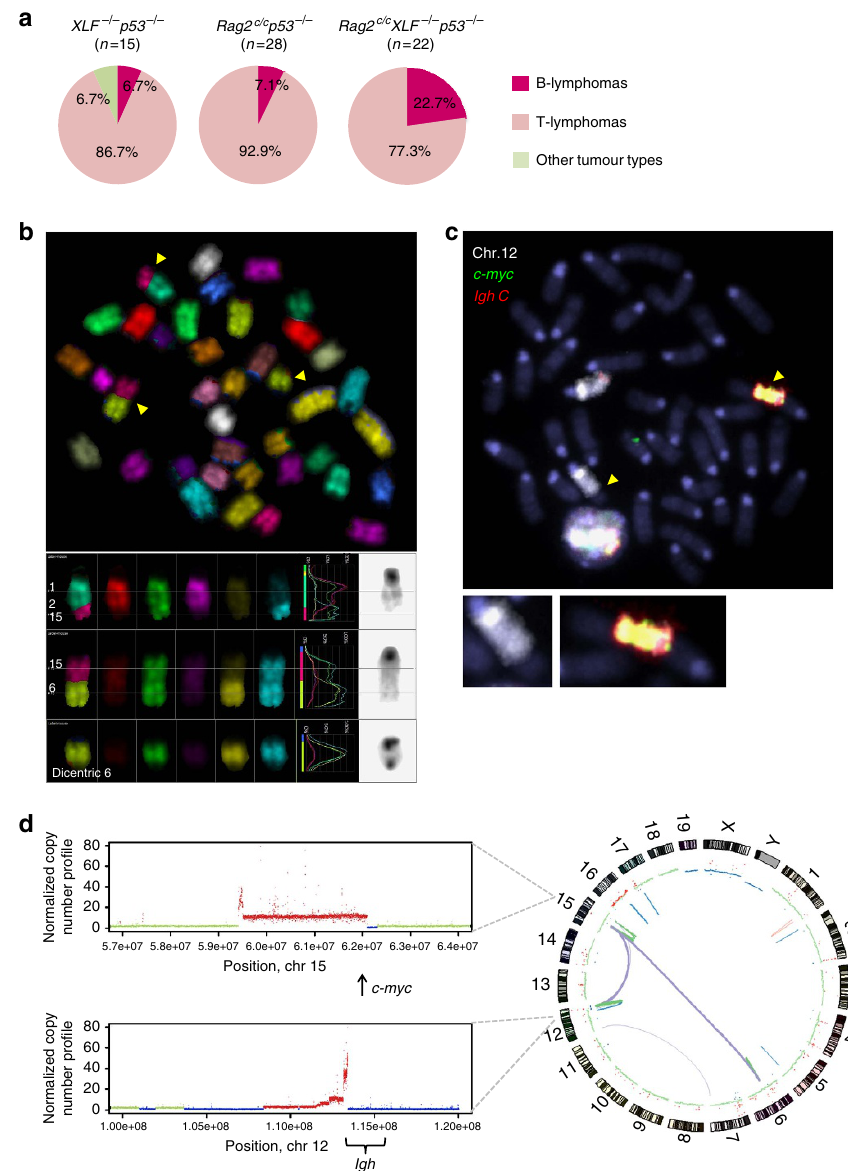
Figure 7 | Rag2 c/c XLF (cid:2) / (cid:2) p53 (cid:2) / (cid:2) mice develop pro-B cell lymphomas harbouring Igh / c-myc translocations associated with gene amplification. ( a ) Tumour spectrum analysis of XLF (cid:2) / (cid:2) p53 (cid:2) / (cid:2) ( n ¼ 15), Rag2 c/c p53 (cid:2) / (cid:2) ( n ¼ 28) and Rag2 c/c XLF (cid:2) / (cid:2) p53 (cid:2) / (cid:2) mice ( n ¼ 22). ( b ) Representative images of spectral karyotyping analysis of 1 Rag2 c/c XLF (cid:2) / (cid:2) p53 (cid:2) / (cid:2) B lymphoma (#14189LN). Five B lymphomas were analysed (see also Supplementary Table 6). ( c ) Representative metaphase from Rag2 c/c XLF (cid:2) / (cid:2) p53 (cid:2) / (cid:2) B lymphoma (#14189LN) using the Igh C BAC probe (red) combined with c-myc BAC probe (green) and chromosome 12 paint (white). Experiments were repeated on five different samples. ( d ) Circos plot showing chromosomal rearrangements of B lymphoma #14189LN identified by WGS. Chromosomes are arranged circularly end-to-end with each chromosome’s cytobands marked in the outer ring. The inner ring displays copy number data inferred from WGS with blue dots indicating losses, red dots indicating gains and green dots indicating normal copy numbers. Within circles, purple, orange, green and blue lines represent inter-chromosomal rearrangements, duplications, inversions and deletions, respectively. The thickness of the link is proportional to the number of read pairs supporting the structural variant. The left panels depict copy number variations in specific regions of chromosome 12 (bottom) and 15 (upper). A total of 3 Rag2 c/c XLF (cid:2) / (cid:2) p53 (cid:2) / (cid:2) B lymphomas were sequenced (see also Supplementary Fig. 11 and Supplementary Data levels of genomic instability at V(D)J loci as compared with ATM- foci accumulate at similar levels in core RAG2 pro-B cells as deficient cells and (4) Rag2 c/c Atm (cid:2) / (cid:2) mice develop aggressive compared with WT pro-B cells and at higher levels in core RAG2/ T-cell lymphomas-bearing complex chromosomal translocations, XLF-deficient cells, indicating that the RAG2 C-terminus is not amplifications and deletions involving the Tcr a / d and Igh loci, required for initial sensing of cleaved DNA ends (that is, the similarly to lymphomas that develop in Atm (cid:2) / (cid:2) and Rag2 c/ phosphorylation of H2AX and accumulation of 53BP1 at RAG c p53 (cid:2) / (cid:2) mice. We do not know yet whether the RAG and ATM- DSBs) by the ATM-DDR machinery. ATM and/or DNA-PKcs DDR end-stabilization/protection function(s) requires direct mediated phosphorylation of RAG1 and RAG2 proteins is not biological interactions between the two complexes. 53BP1/ g H2AX required for recombination of chromosomally integrated substrates